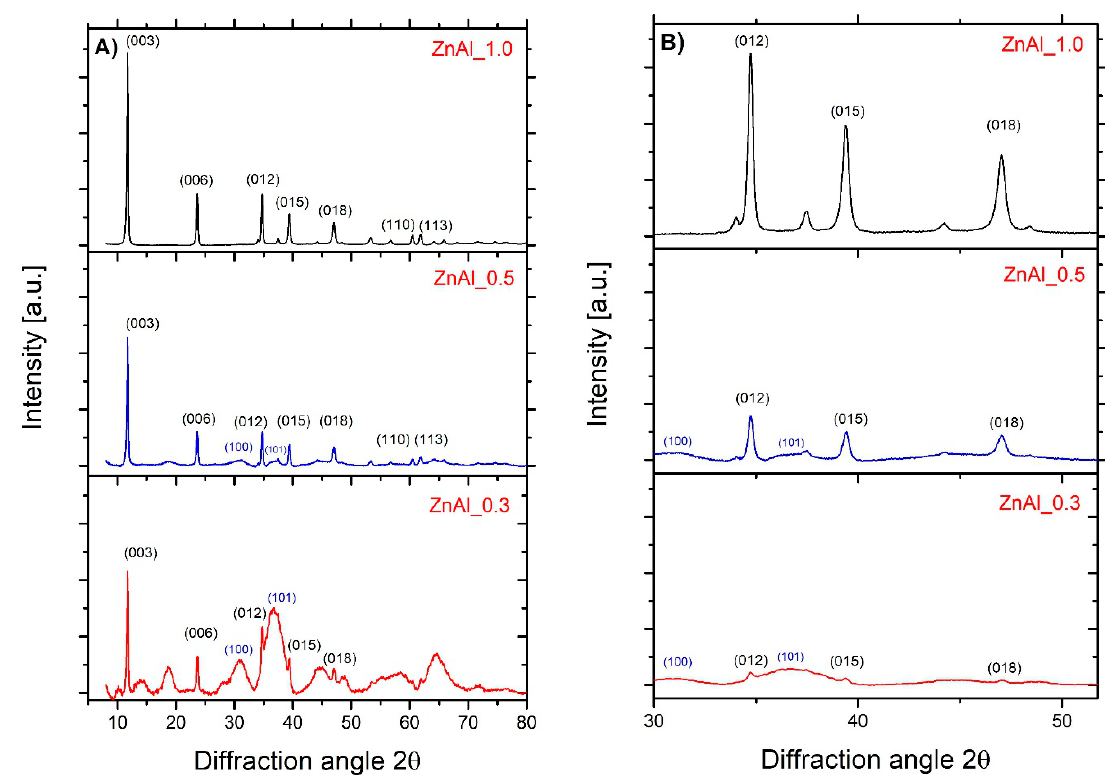
Figure 1. ( A ) XRD patterns of ZnAl-LDHs with di ff erent Zn / Al molar ratios; Zn 0.63 Al 0.37 (OH) 2 (CO 3 ) 0.185 · xH 2 O phase bands at 2 θ : 11.79 ◦ (003), 23.69 ◦ (006), 34.78 ◦ (012), 39.47 ◦ (015), 44.27 ◦ (018), 60.50 ◦ (110), and 61.88 ◦ (113); ZnO phase peaks at angles 2 θ : 31.8 ◦ (100) 36.1 ◦ (101). ( B ) XRD patterns of ZnAl-LDHs with di ff erent Zn / Al molar ratios at 2 θ from 30 to 55 ◦ . Catalysts 2020 , 10 , x FOR PEER REVIEW